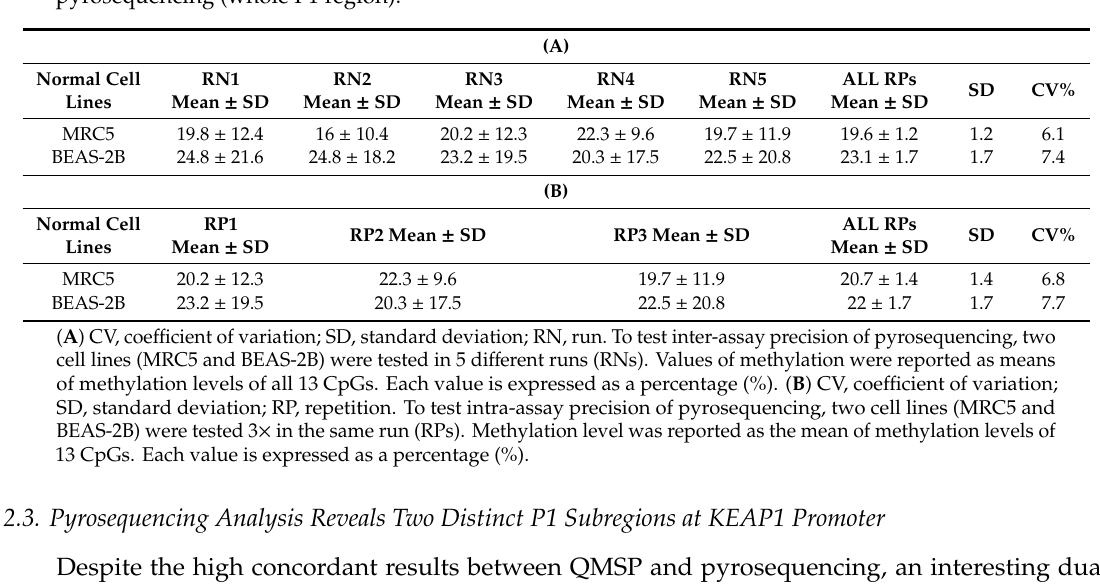
Table 2. ( A ) Inter-assay precision for KEAP1 P1 promoter methylation analysis by